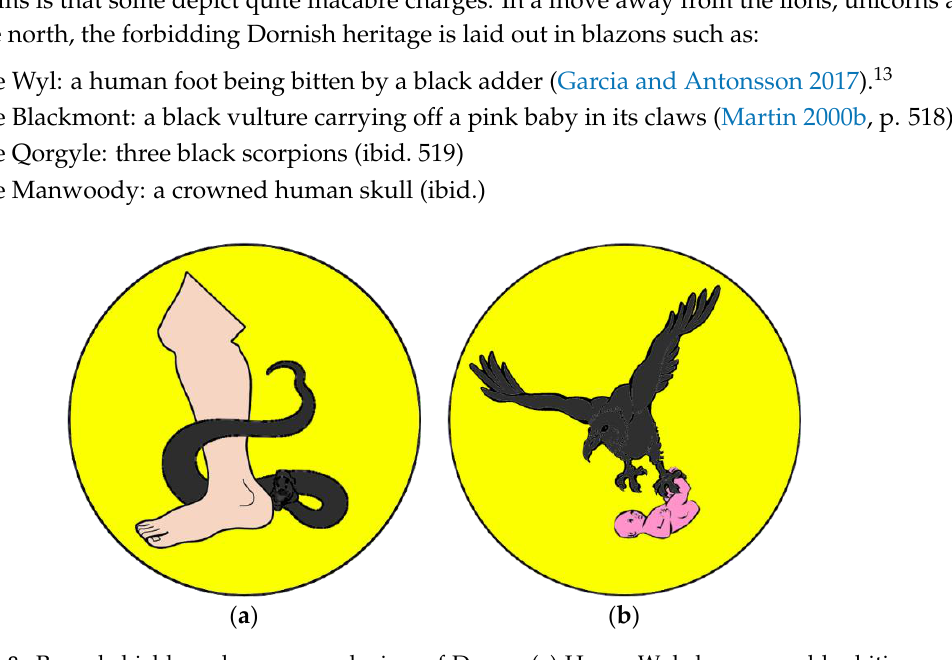
Figure 8. Round shields and gruesome devices of Dorne: ( a ) House Wyl shows an adder biting a human foot (A Wiki of Ice and Fire: WylCOA.png n.d.); ( b ) Hose Blakmont depicts a vulture carrying away a child (A Wiki of Icae and Fire: BlackmontCOA.png 2013).